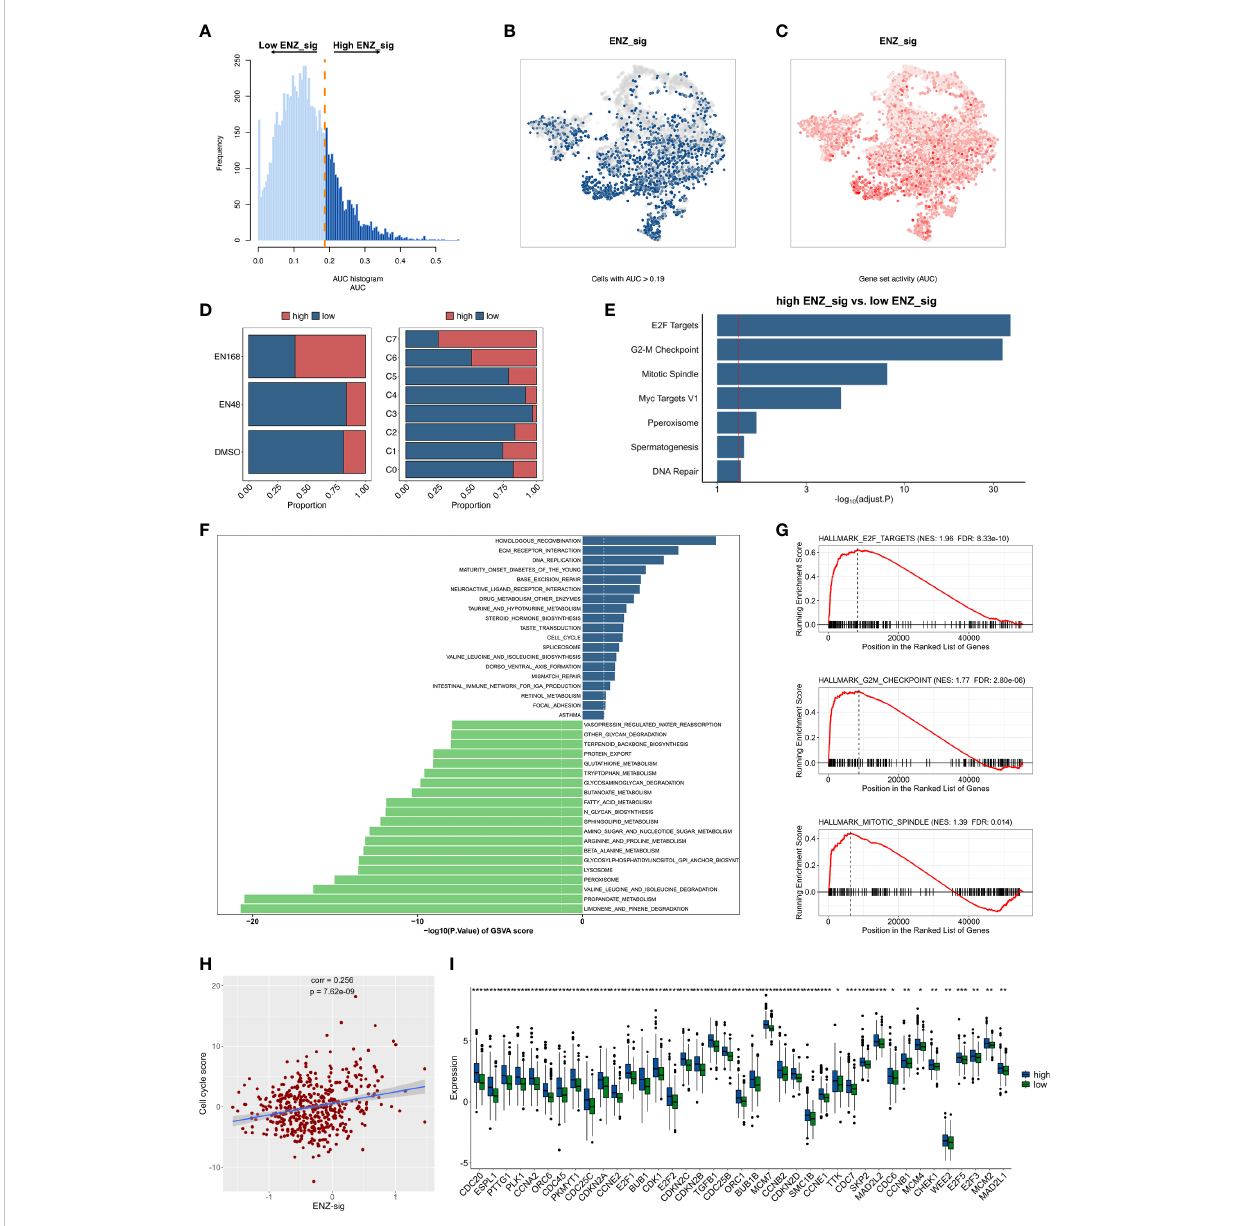
FIGURE 6 Biological pathway enrichment related to enzalutamide-induced signature. (A) The distribution of AUC and cell frequency. (B) AUC and cell frequency. (B) T-distributed stochastic neighbor embedding (Tsne) diagram for cells with AUC higher than selected threshold. Blue dots indicate cells with higher than 0.19, and gray dots indicates cells with less than 0.19. (C) Tsne diagram for ENZ-sig activity that colored by AUC. The deeper color represents a larger AUC. (D) The distribution of high ENZ-sig cells and low ENZ-sig cells in enzalutamide-stimulated models and clusters. (E) Bar plot for enrichment analysis based on the differentially expressed genes between high ENZ-sig and low ENZ-sig group. Red dotted line represents adjusted p-value less than 0.05. (F) Gene set variation analysis between high-risk and low-risk group strati fi ed by enzalutamide-induced signature. Dotted line indicates p-value less than 0.05. (G) Gene set enrichment analysis in the high-risk group and the low-risk group. (H) Correlation between ENZ-sig and cell cycle score in PCa. (I) Box plot shows the statistically signi fi cant genes related to cell cycle pathway between the high-risk and low-risk groups. Statistical signi fi cance: *p < 0.05; **p < 0.01; ***p < 0.001; ****p <